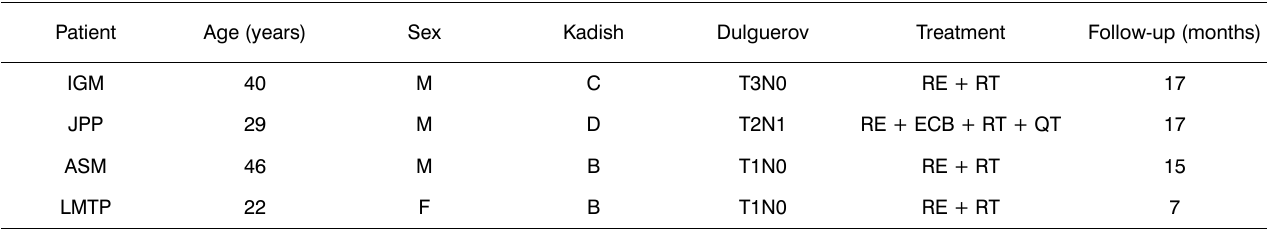
Table 3. Data on patients, treatment and follow-up.